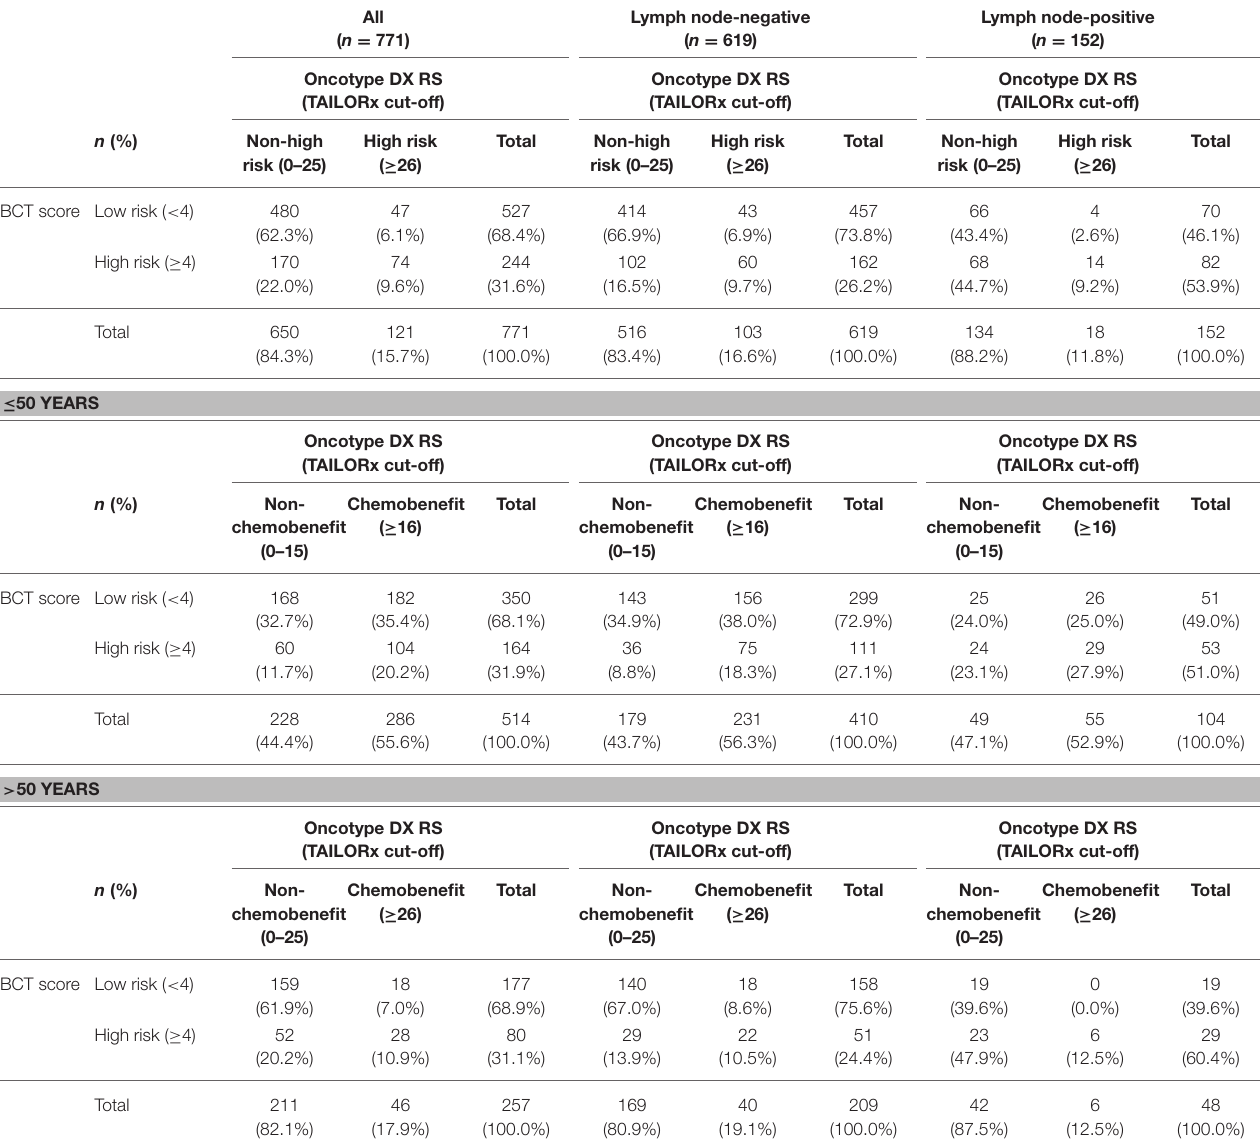
TABLE 2 | Concordance in risk stratification between the BCT score and Oncotype DX RS according to nodal status and age.